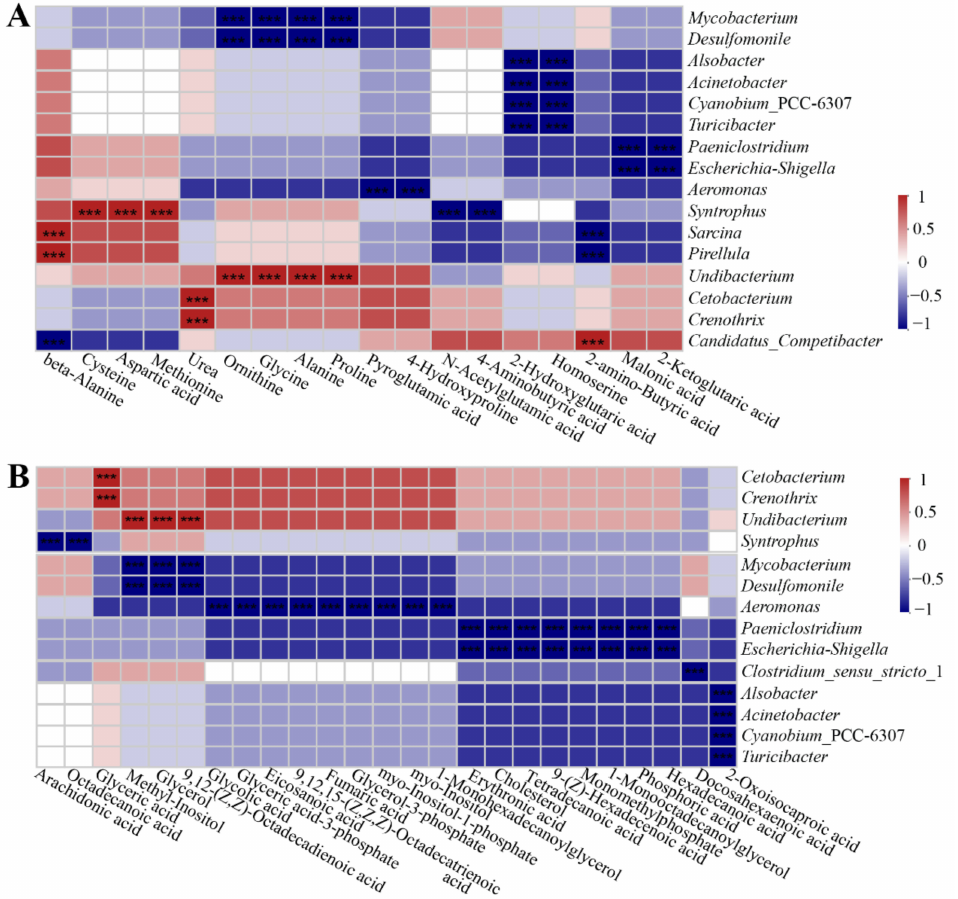
Figure 6. The significant correlation between intestinal main bacterial genera and metabolites. ( A ) The correlation of intestinal bacteria and amino acid-related metabolites. ( B ) The correlation of intestinal bacteria and lipid-related metabolites. The correlation coefficient is represented by different colors (red: positive correlation; blue: negative correlation). * Represents significantly negative or positive correlations (*** p <